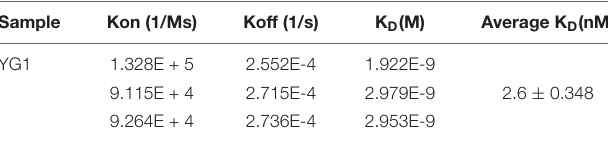
TABLE 1 | Association and dissociation rate constants and apparent binding constants for YG1 MAb.